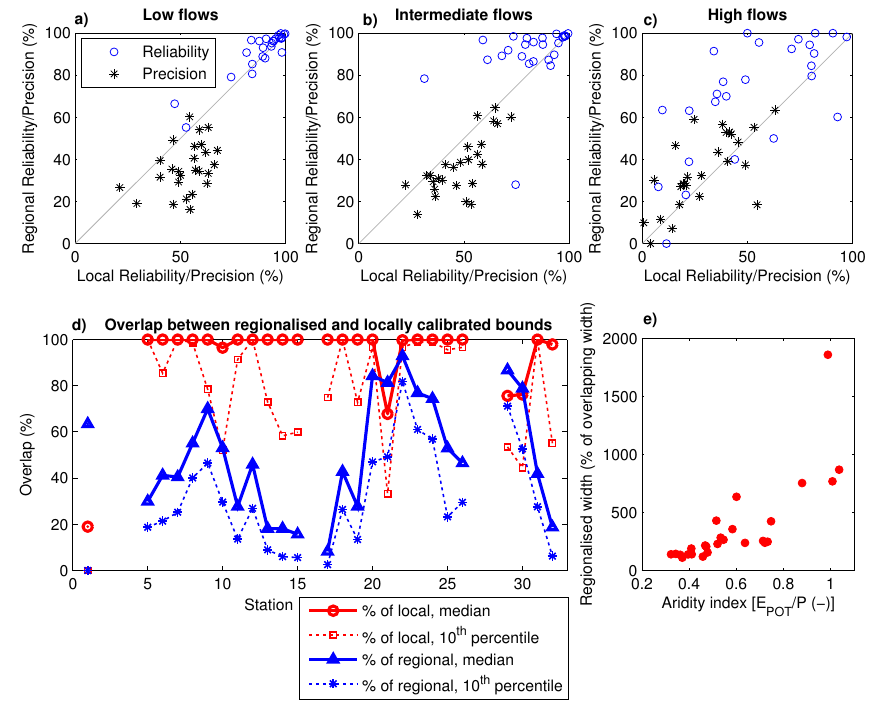
Figure 12. Comparison of observed and simulated uncertainty bounds for simulations constrained with local and regionalised FDCs for (a) low, (b) intermediate and (c) high flows for the 26 basins that had behavioural local simulations; (d) comparison of regionally constrained and locally calibrated uncertainty bounds – the overlapping range between these bounds is expressed as a percentage of the width of the locally calibrated and the regionalised bounds respectively and the 10th percentile and median values of the distribution for each time series are shown; (e) width of the regionalised bounds as a percentage of the width of the overlapping area between the regionalised and the locally calibrated uncertainty bounds, then taken as the average value for the whole time series, plotted against the aridity